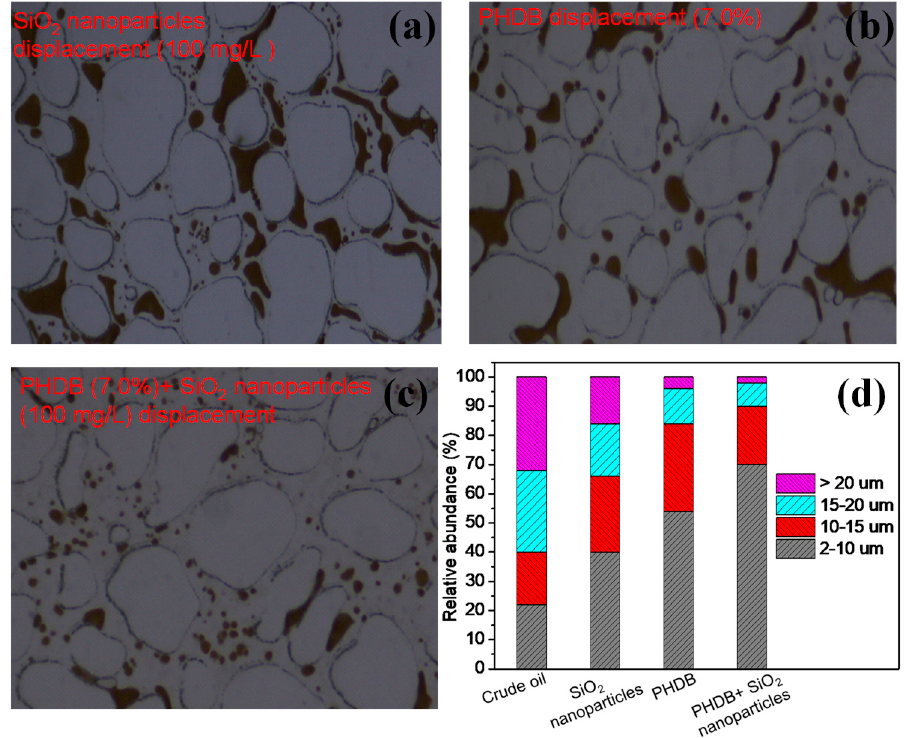
Figure 3. Characteristics of distribution and formation of residual oil under the maximum concentration of different displacement fluids ( a – c ), and corresponding droplet size distribution of residual oil emulsion ( d ).